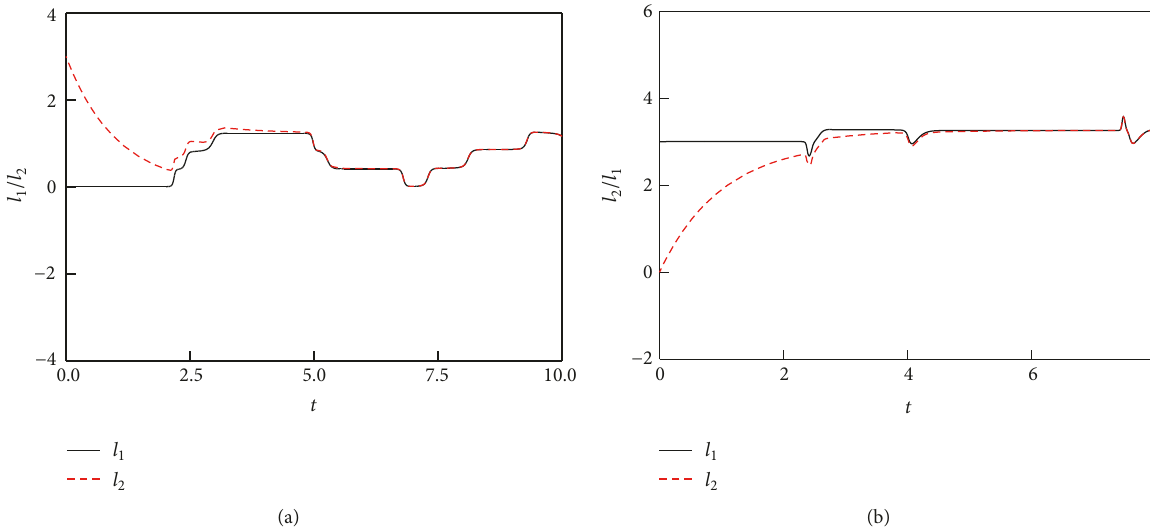
Figure 10: Timing diagrams: (a) case 1 , 𝑙 1 = 0 & 𝑙 2 = 3 , and (b) case 2 , 𝑙 1 = 3 & 𝑙 2 = 0 .